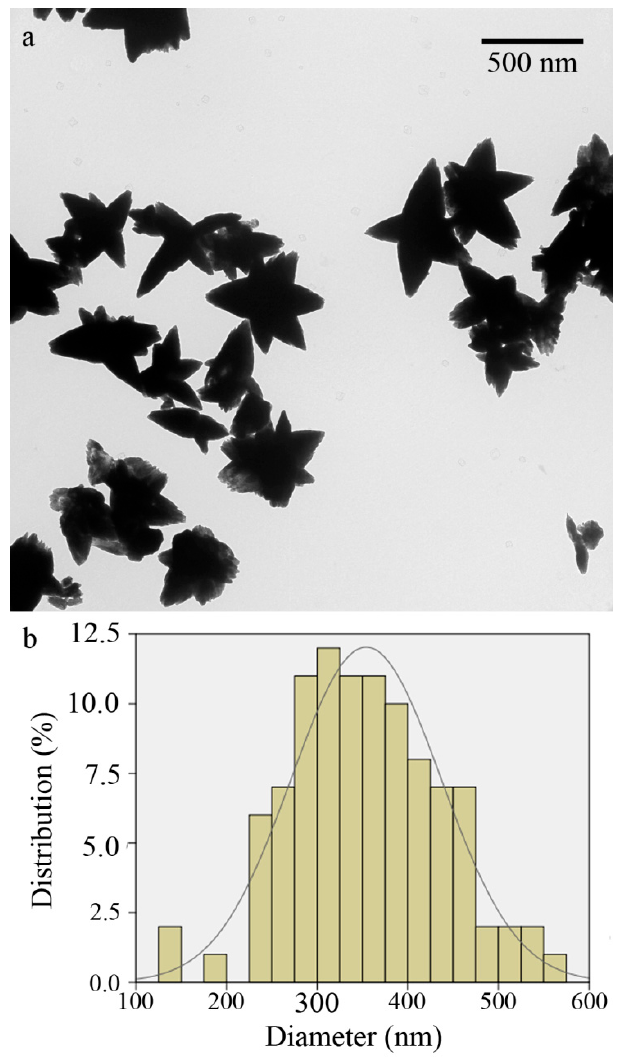
Figure 4. ( a ) Transmission electron microscopy (TEM) micrograph of XG-capped ZnO microstars and ( b ) corresponding histogram with normal distribution.